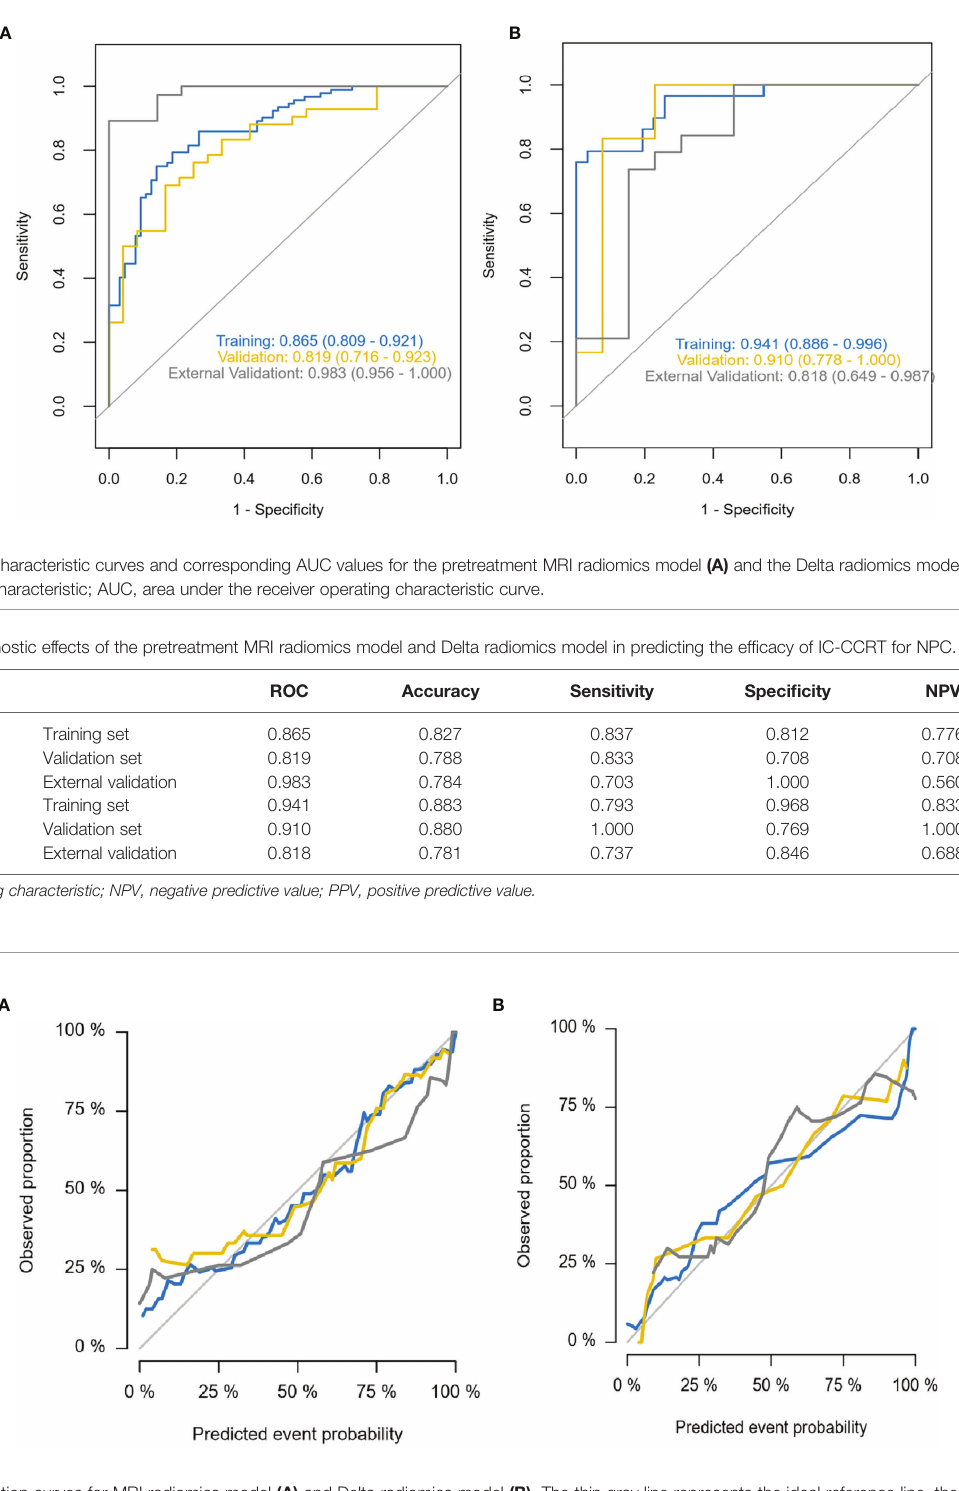
FIGURE 6 | Calibration curves for MRI radiomics model (A) and Delta radiomics model (B) . The thin gray line represents the ideal reference line, the blue line represents the training set, the yellow line represents the internal validation set, and the thick gray line represents the external validation set. In this reference line, regardless of the training set, internal validation set, or external validation set, the predicted probability matches the observed proportion, indicating that both models have good performance in judging the tumor retraction of NPC primary tumors after IC-CCRT treatment. NPC, nasopharyngeal carcinoma; IC-CCRT, induction chemotherapy combined with concurrent